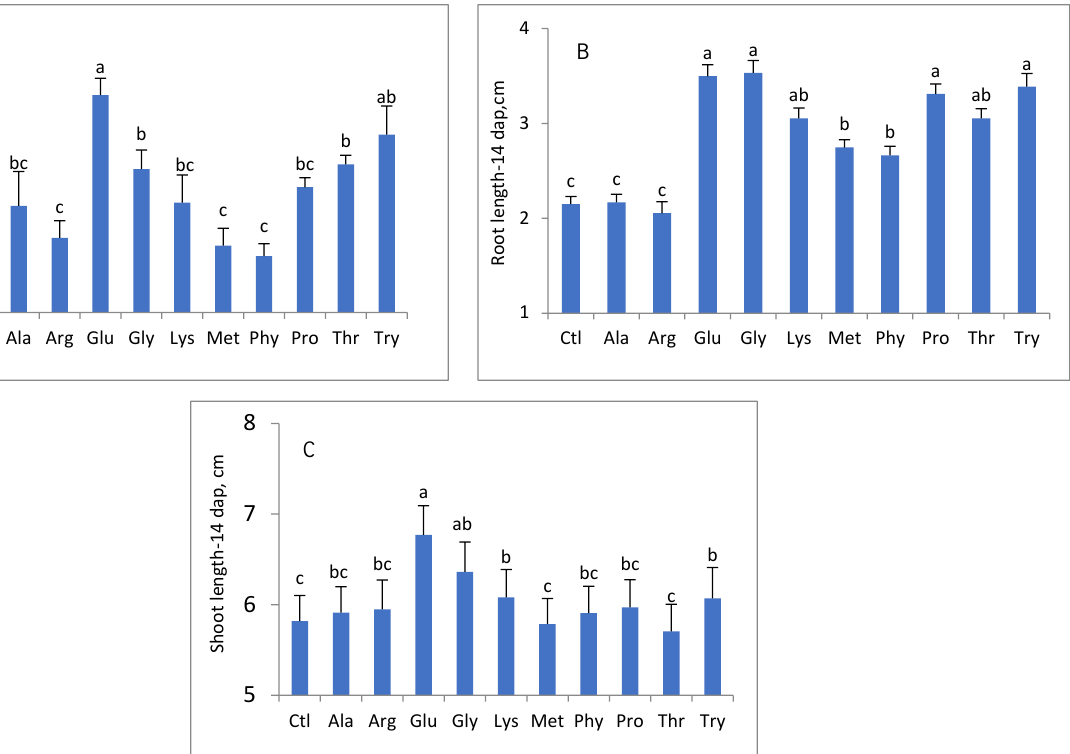
Figure 3. Effect of priming onion seeds with exogenous amino acids. ( A )—Shoot length, cm (SL-7); ( B )—Root length, cm (RL-14); ( C )—Shoot length, cm ((SL-14)). Ctl (Control); Ala (Alanine); Arg (Arginine); Glu (Glutamine); Gly (Glycine); Lys (Lysine); Met (Methionine); Phy (Phenylalanine); Pro (Proline); Thr (threonine); Try (tryptophan). Columns that share the same letter(s) are not statistically significant at p ≤ 0.01.